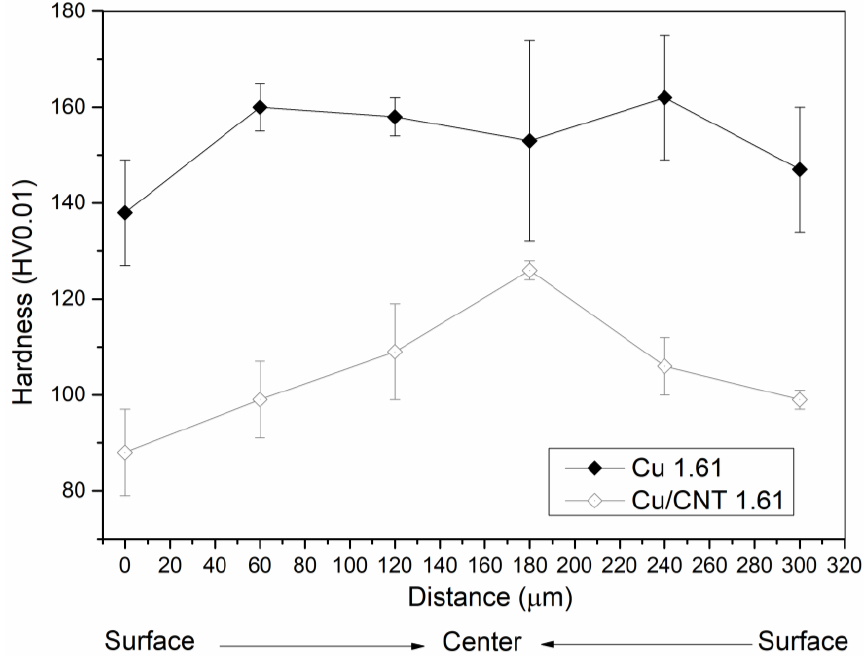
Figure 16. Hardness profiles of Cu and Cu/CNT samples after cold rolling to a strain of 1.61.